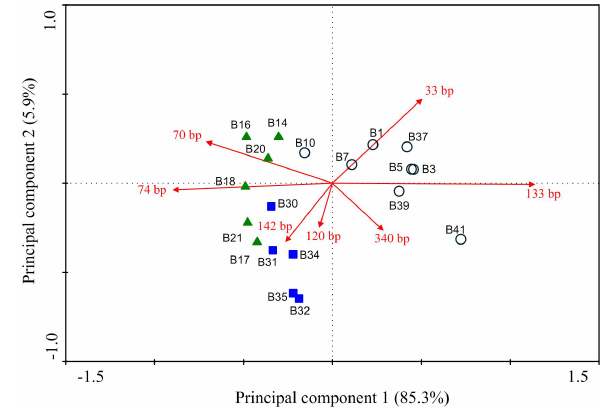
Figure 3. Comparison of alkB gene based T-RFLP profiles obtained from different Fig. 3. Comparison of alkB -based T-RFLP profiles obtained from different soil samples. Values are mean ± S.D. ( n = 3). Msp I was soil samples. Values are mean ± S.D. (n = 3). Msp I was used as restriction enzyme. used as restriction enzyme. OS=oil field surface soil; GS=gas field OS = oilfield surface soil; GS = gasfield surface soil, BS = background soil (B3, B14 surface soil; BS=background soil (B3, B14 and B34). Numbers 1– 3 indicate field replicates from the corresponding sites. and B34 sampling site are representing background soil, oil field soil and gas field soil, respectively. Numbers 1-3 indicate field replicates from the corresponding sites).